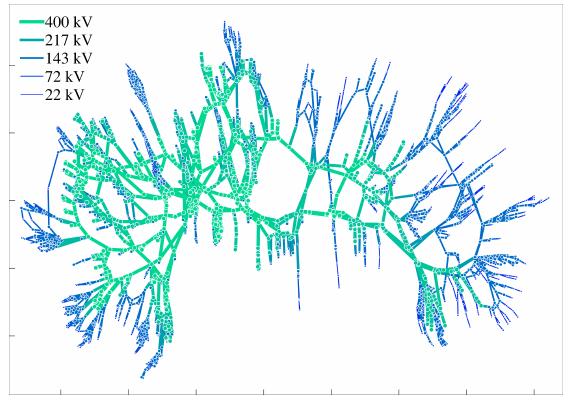
Figure 1. This diagram shows the nesta_case2224_edin test power